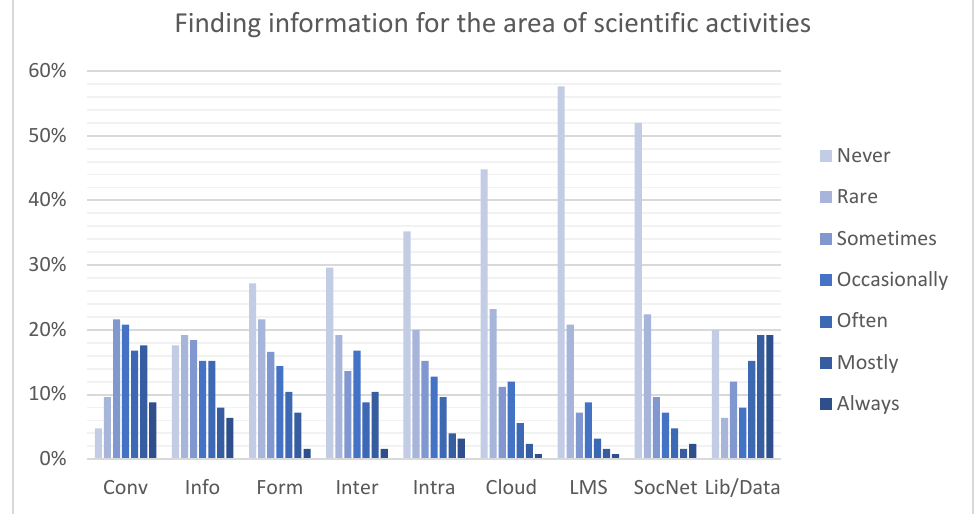
Figure 2. Ways of finding information in the area of scientific activities. (The complete legend is shown in Tables 1 and 2).